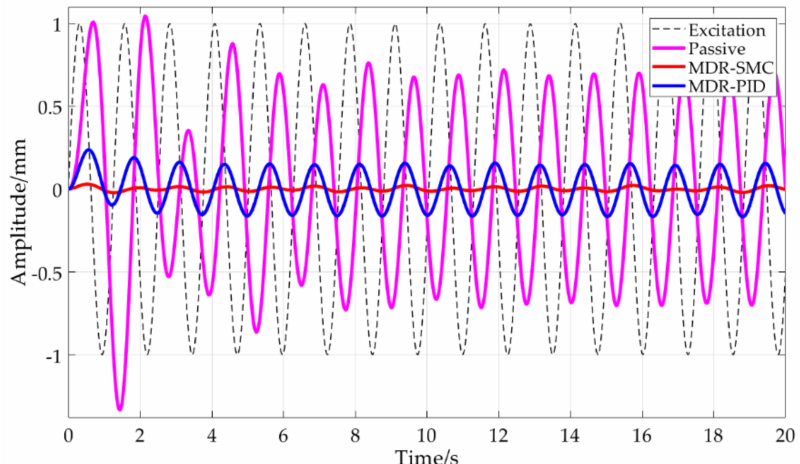
Figure 20. Comparison of the SMC with MRD, PID with MRD, and the passive system under excitation of a sinusoidal signal with an amplitude of 1 mm and a frequency of 5